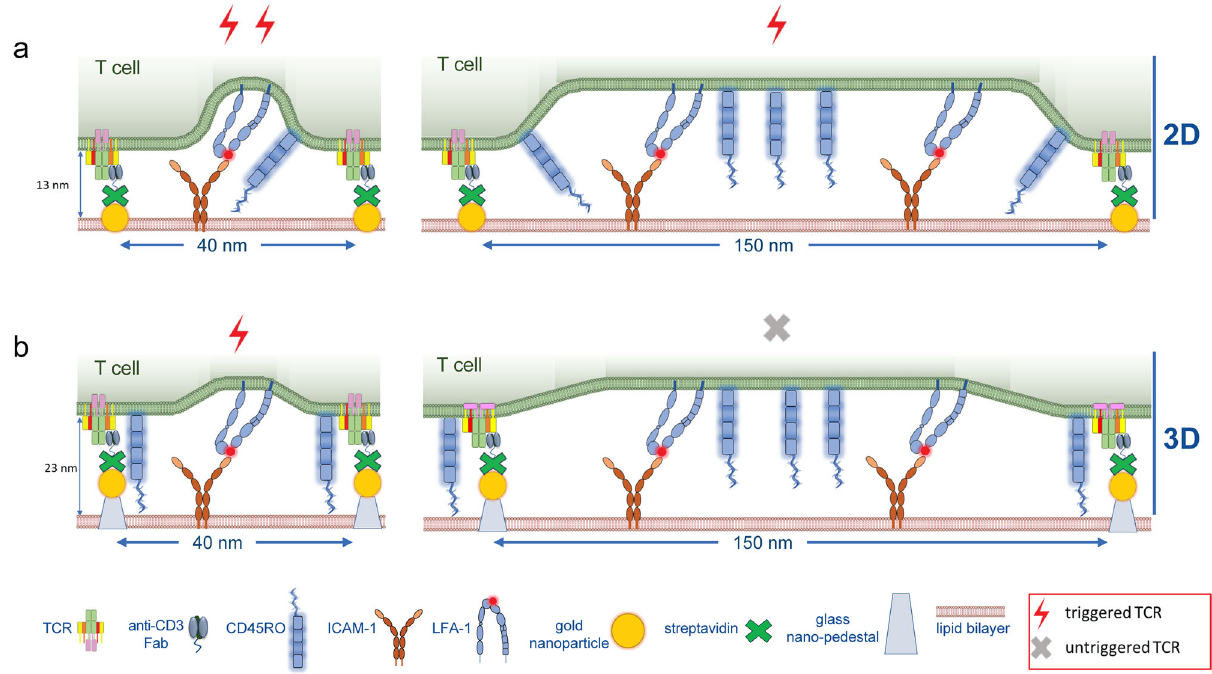
Fig. 8 Membrane curvature and CD45 exclusion contribute to TCR triggering. Micropatterned surfaces were prepared in 2D with gold nanoparticles (NPs) at the same level as an SLB ( a ) or in 3D with gold NPs elevated 10 nm on SiO 2 pillars above the SLB ( b ). Anti-CD3 Fab was linked to NPs and ICAM-l molecules were present on the SLB for adhesion. Large membrane curvature is generated at engaged TCR clusters in the 2D system to accommodate large ICAM-1/LFA-1 complexes ( a ) whereas elevation of anti-CD3 Fab in the 3D system generates less membrane curvature for a given ligand spacing ( b ). However, when the distance between NP pillars is reduced to 40 nm TCR signaling is restored ( b , left). This might be explained by a high degree of membrane curvature when ICAM-1/LFA-1 interactions are interspersed with the closely spaced pMHC/TCR ( b , left). While ICAM-1 didn ’ t accumulate in 3D TCR clusters with 40 nm spacing, a relatively small number of interspersed ICAM-1/LFA-1 interactions would be suf fi cient to enforce curvature; further work is required to test for high curvature in the 3D 40 nm